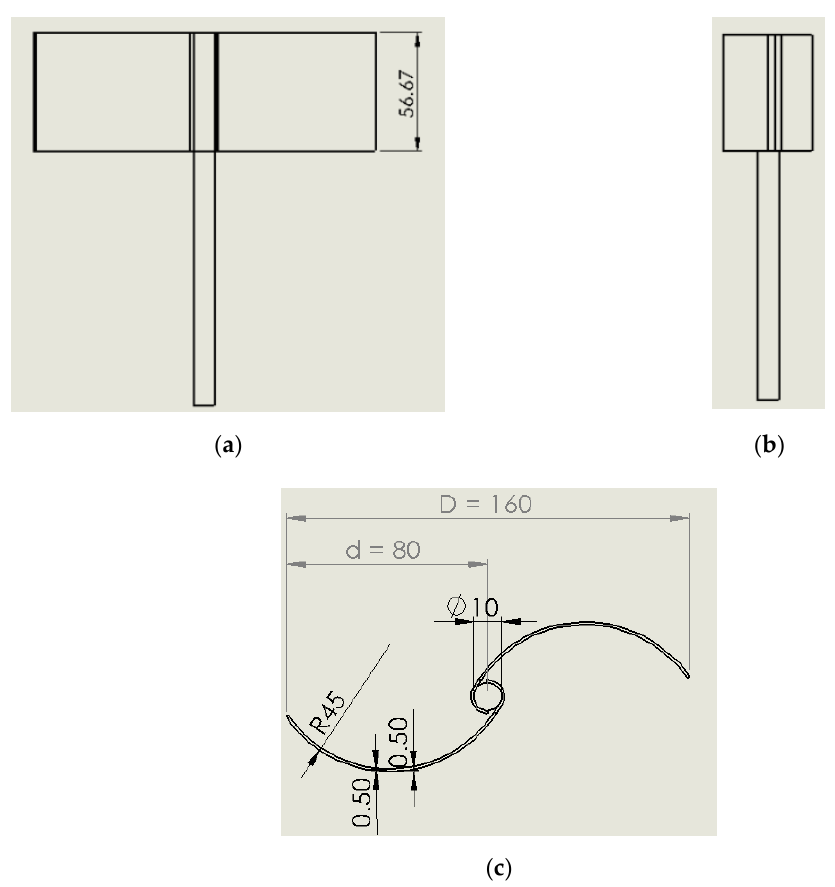
Figure 15. The Savonius turbine’s three views (dimensions are in mm): ( a ) elevation, ( b ) side view, and ( c ) plan.